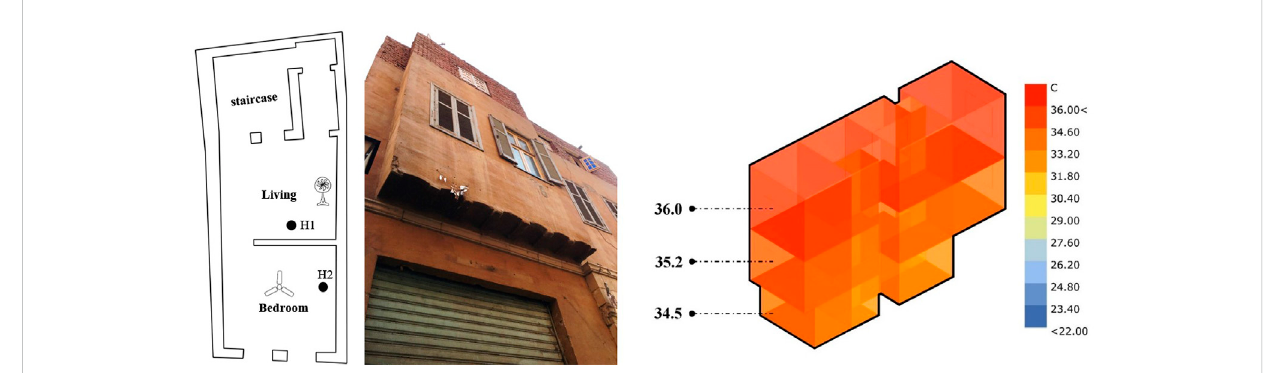
FIGURE 5 Left, An example fl oor plan for a representative archetype and location of the Hobo data logger, Right, hourly operative temperature simulation for the warmest summer week (19 th to 25 th of August).